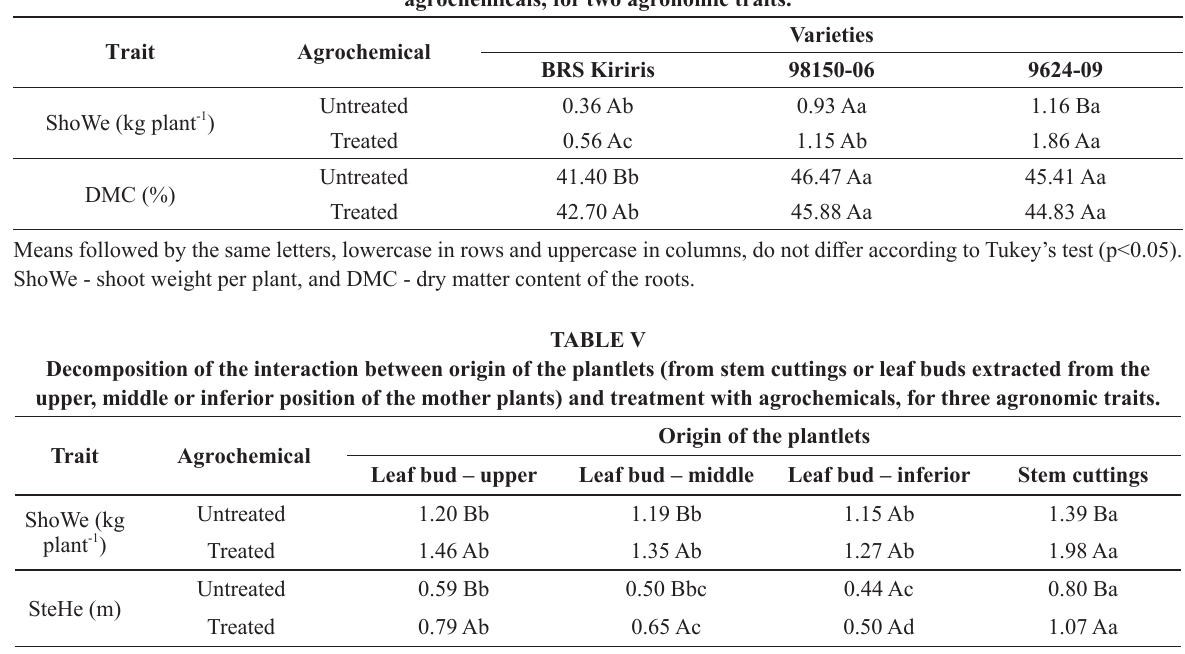
Decomposition of the interaction between cassava varieties (BRS Kiriris, 98150-06 and 9624-09) and treatment with agrochemicals, for two agronomic traits.